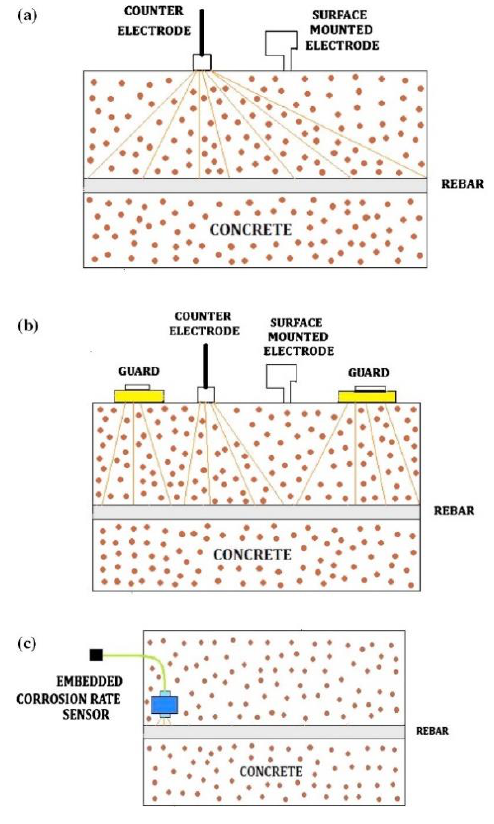
Figure 8. Design of sensor assembly ( a ) surface mounted, ( b ) guard ring and ( c ) embedded corrosion rate monitoring probe sensor. Reproduced with permission from ref. [107]. Copyright 2014